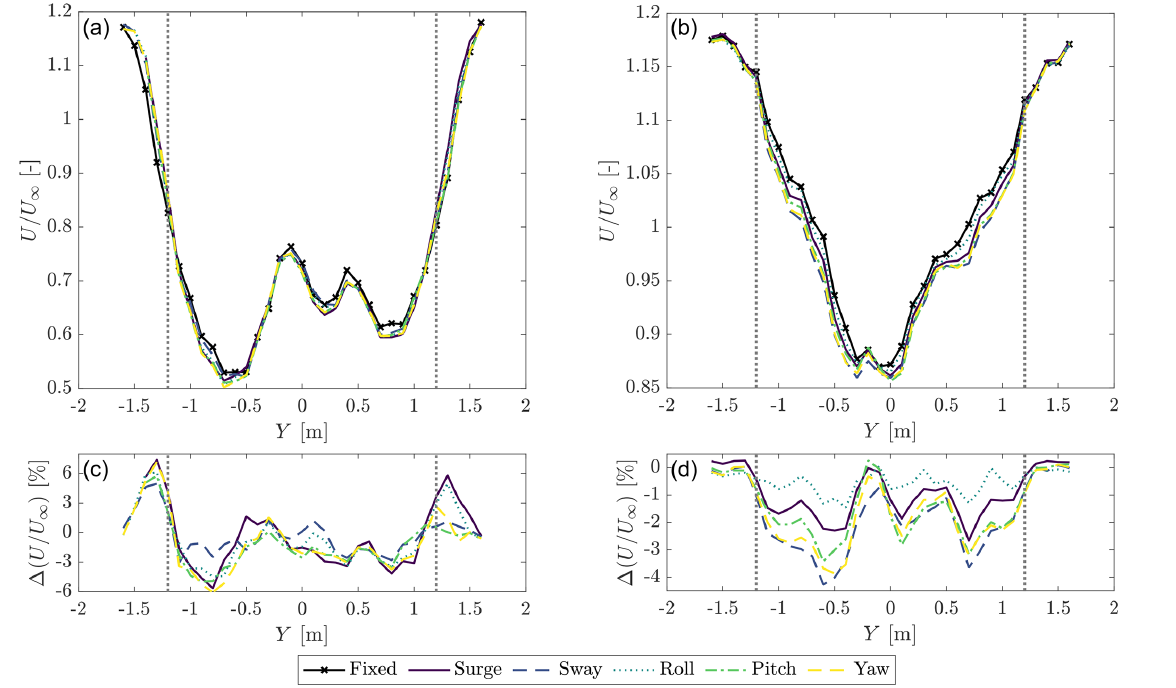
Figure 7. Average wake deficit at X = 2 . 3 D for the fixed case and with different motions at the wave frequency, in WC1 (a) and WC2 (b) . (cid:49) ( U/U ∞ ) is the wake deficit increment with motion with respect to the fixed case (WC1: c ; WC2: d ). The vertical dotted lines mark the edge of the rotor.